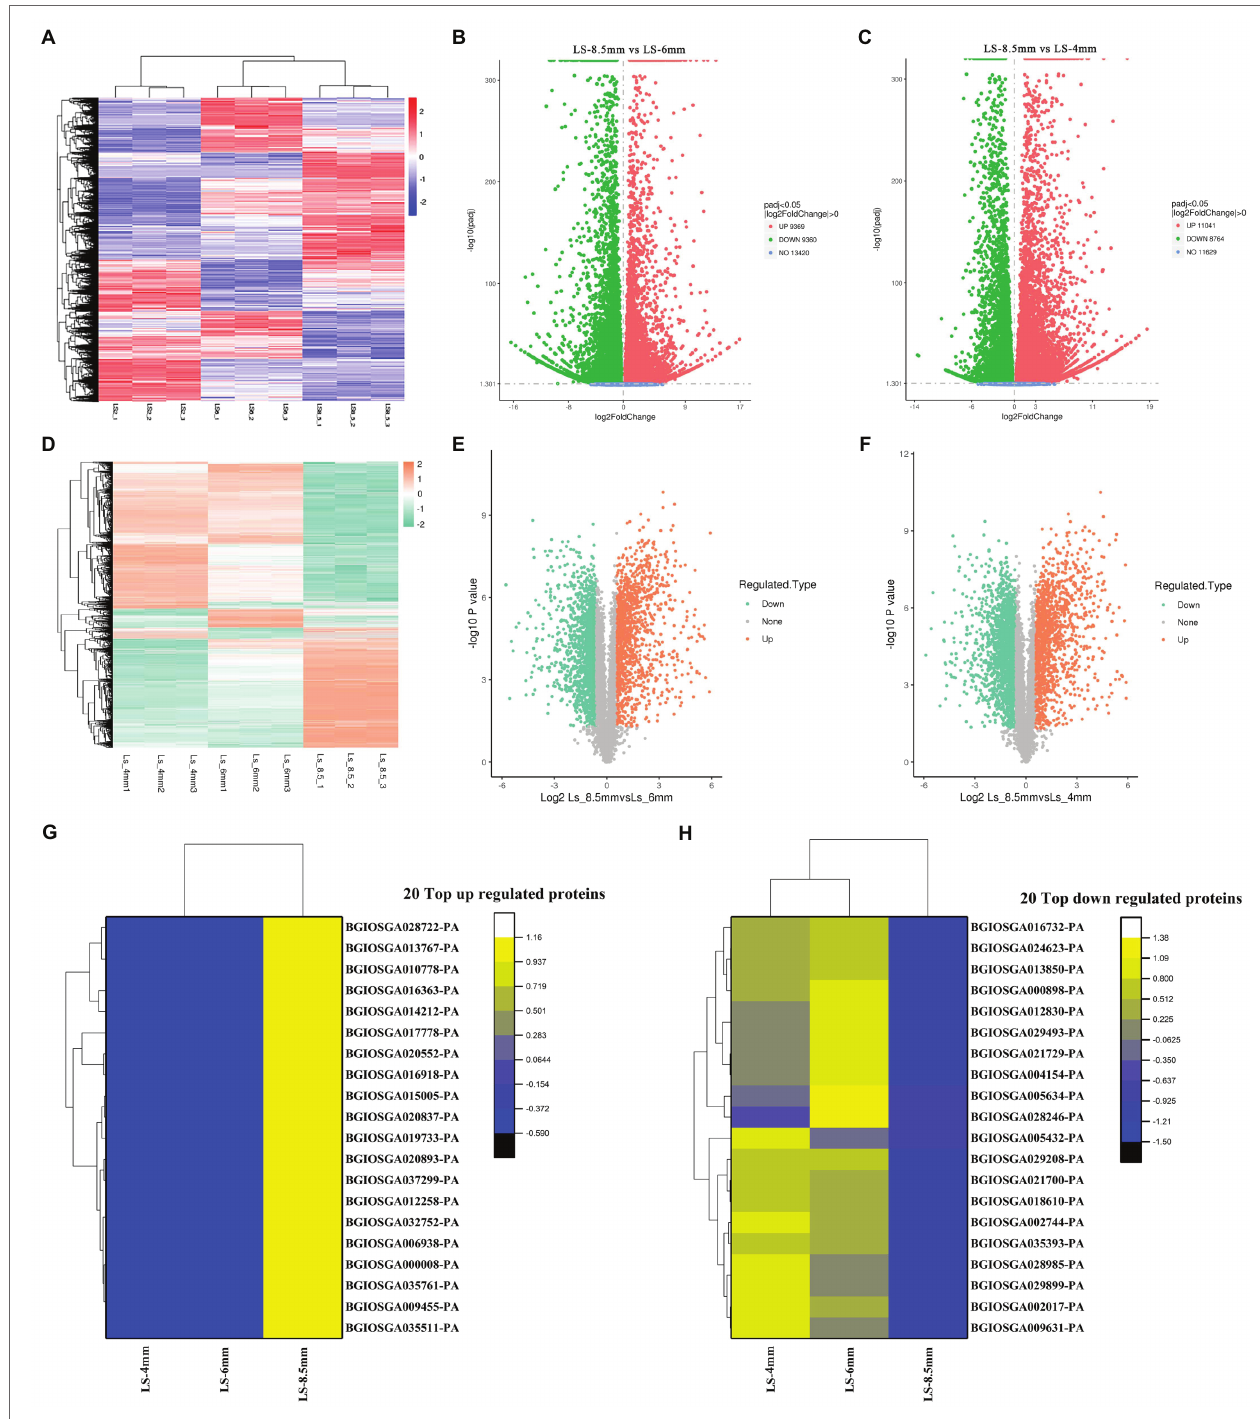
FIGURE 5 | Differentially expressed genes (DEGs) and differentially expressed proteins (DEPs) between anthers from different spikelet growth stages in O. longistaminata . (A) Heatmap of fold-change differences in gene expression among samples from three spikelet stages. (B) Volcano plot of DEGs between Ls-8.5 mm and Ls-6 mm. (C) Volcano plot of DEGs between Ls-8.5 mm and Ls-4 mm. (D) Heatmap of fold-change differences in protein expression among samples from three spikelet stages. (E) Volcano plot of DEPs between Ls-8.5 mm and Ls-6 mm. (F) Volcano plot of DEPs between Ls-8.5 mm and Ls-4 mm. The ordinate represents the multiple of difference and the ordinate represents the level of significance. The scatter in the upper left corner represents significant gene/protein expression, differentially upregulated. The scatter in the upper right represents significant gene/protein expression, differentially upregulated. (G) Heat map of 20 top up regulated proteins at Ls-4 mm, Ls-6 mm and Ls-8.5 mm spikelets. (H) Heat map of 20 top down regulated proteins at Ls-4 mm, Ls-6 mm and Ls-8.5 mm